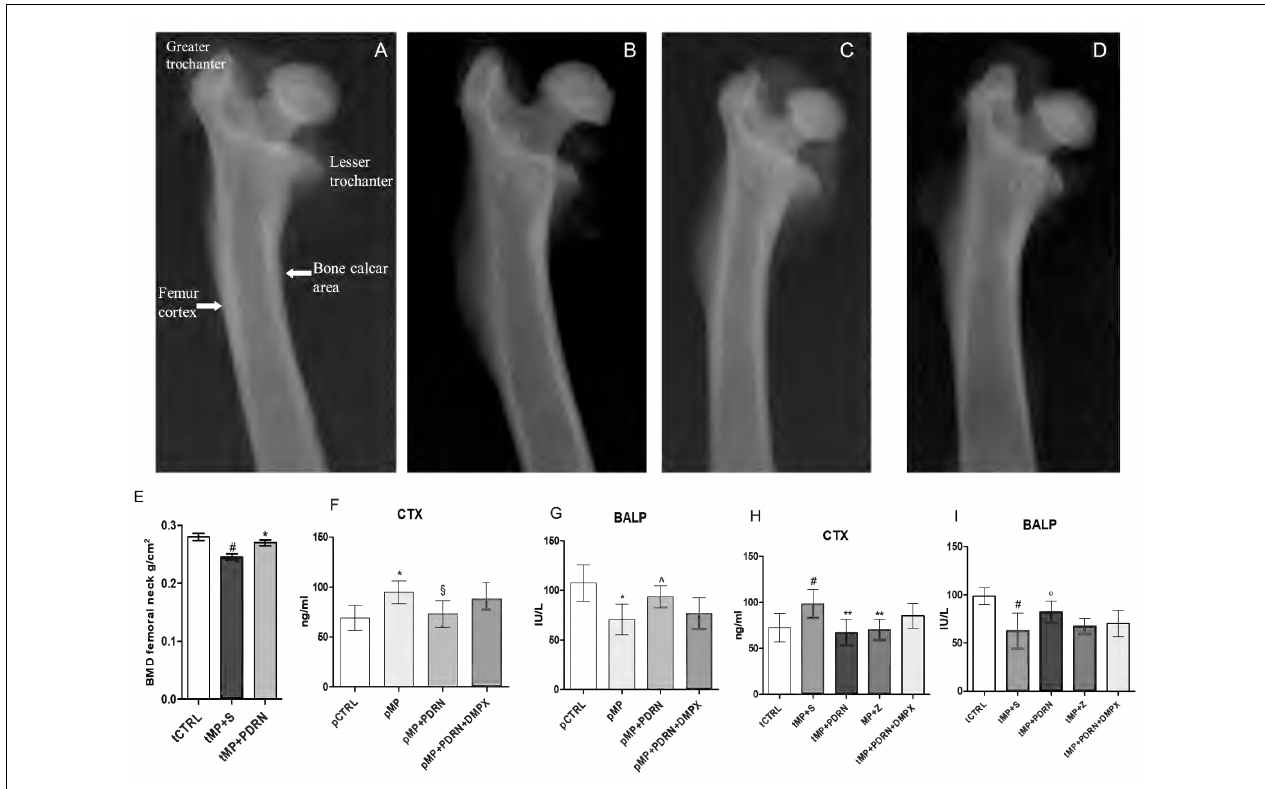
FIGURE 2 | Bone x-rays and markers. (A–D) Representative X-ray images obtained from the several study group. (A) tCTRL, (B) tMP+S, (C) tMP+PDRN, (D) tMP+Z. (E) BMD at femoral neck expressed as g/cm 2 in the several groups. ∗ p < 0.05 vs. tMP+S; # p < 0.05 vs. tCTRL. Data are expressed as means and SD. Bone resorption (CTX; F,H ) and formation (BALP; G,I ) markers evaluated in the several study groups. ∗ p < 0.005 vs. pCTRL; § p < 0.01 vs. pMP; ∧ p = 0.02 vs. pMP; # p < 0.005 vs. tCTRL; ∗∗ p < 0.01 vs. tMP+S; ◦ p < 0.05 vs. tMP+S. Data are expressed as means and